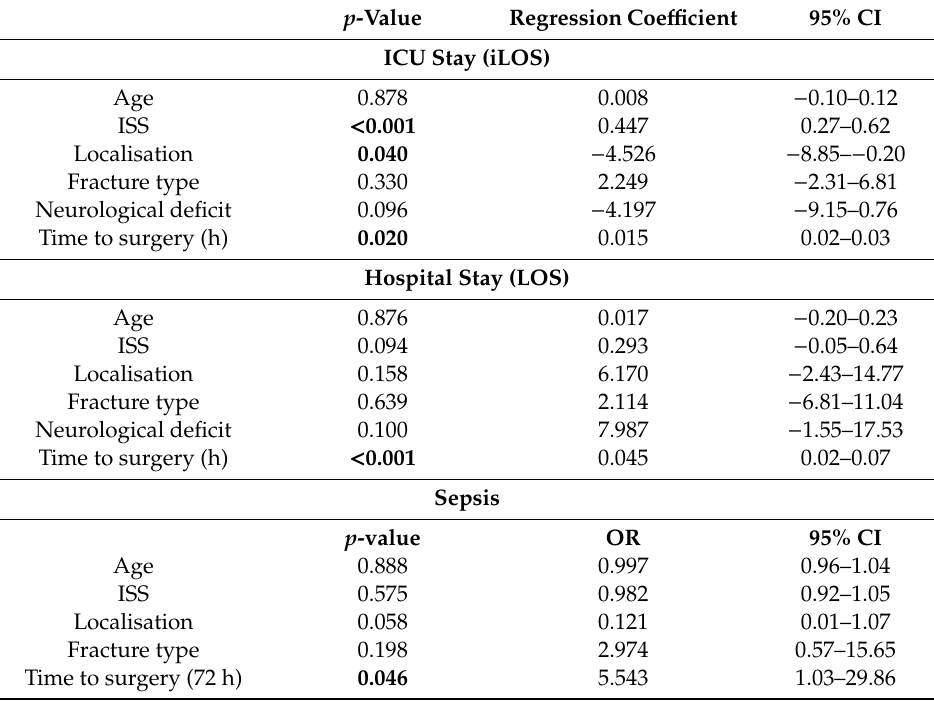
Table 7. Regression analysis with the dependent variables: LOS (days), length of stay in intensive care (iLOS; days), and